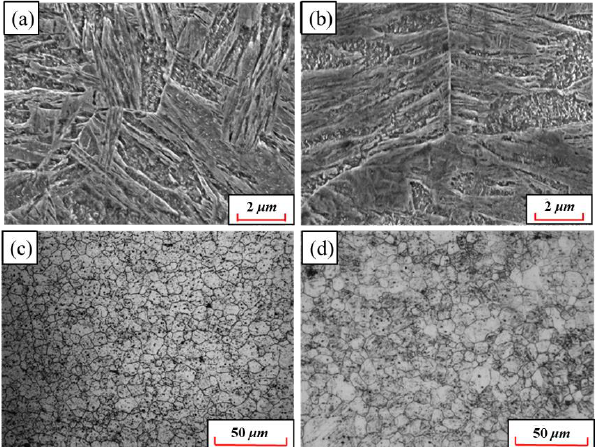
Figure 17. Comparison of microstructures and grains between 22MnB5NbV and 22MnB5 steel: ( a ) microstructure of 22MnB5NbV; ( b ) microstructure of 22MnB5; ( c ) grain of 22MnB5NbV; ( d ) grain of 22MnB5.